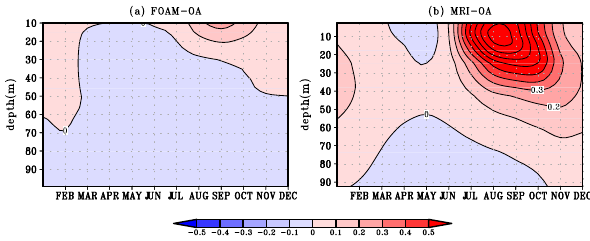
Fig. 9. Change in seasonal variation of upper ocean potential tem- perature ( ◦ C) averaged over northern high latitudes (60 ◦ N–90 ◦ N) for (a) FOAM-OA, (b) MRI-OA.